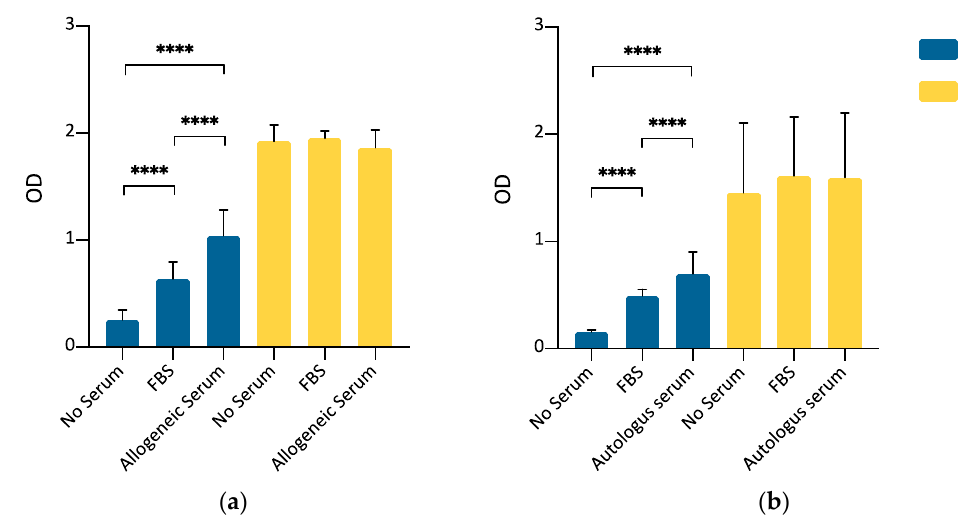
Figure 8. ( a ) Comparison between FBS and allogeneic canine serum as a medium supplement for ADMSCs culture, by MTT assay (5000 cells / well; 72 h). When seeded on plastic (blue bars), supplementation of medium with 10% allogeneic serum induced a statistically significant stimulus to cell growth with respect to FBS. When cells were cultured inside a 3D fibrin-based matrix prepared from PPP (yellow bars), allogeneic serum, and FBS supplementation, or no supplementation in the culture medium, did not induce different cell growth. Statistically significant differences are indicated as follows: **** p ≤ 0.0001 (n = 3). ( b ) Autologous serum as a substitute for FBS in medium supplementation for ADMSCs growth (5000 cells/well; 72 h). When cells were cultivated on plastic surface (blue bars), 10% autologous serum medium supplementation was an effective substitute for 10% FBS supplementation. When cells were seeded inside a 3D fibrin-based matrix (yellow bars), no serum supplementation, FBS or autologous serum supplementation induced comparable results. Statistically significant differences are indicated as follows: **** p ≤ 0.0001 ( n = 3).